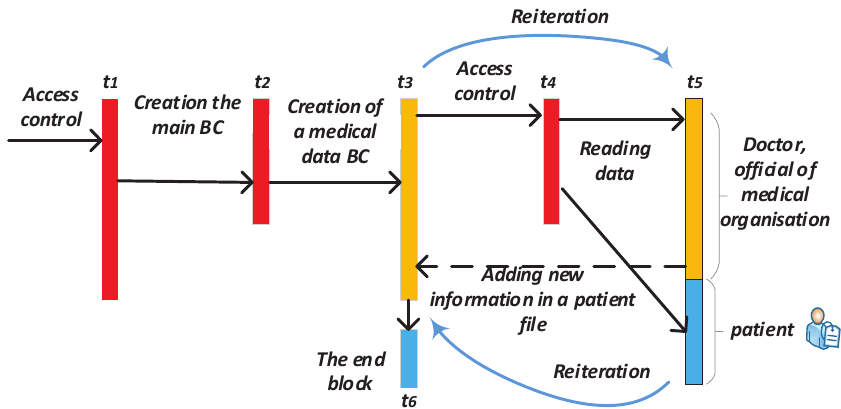
Figure 10. Scheme of possible time steps of the proposed method use for the Blockchain Tree